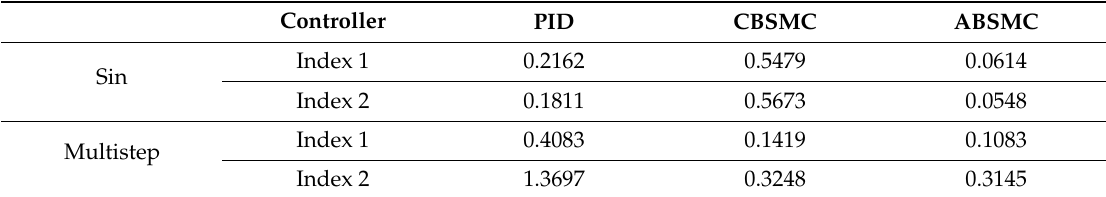
Table 1. Performance